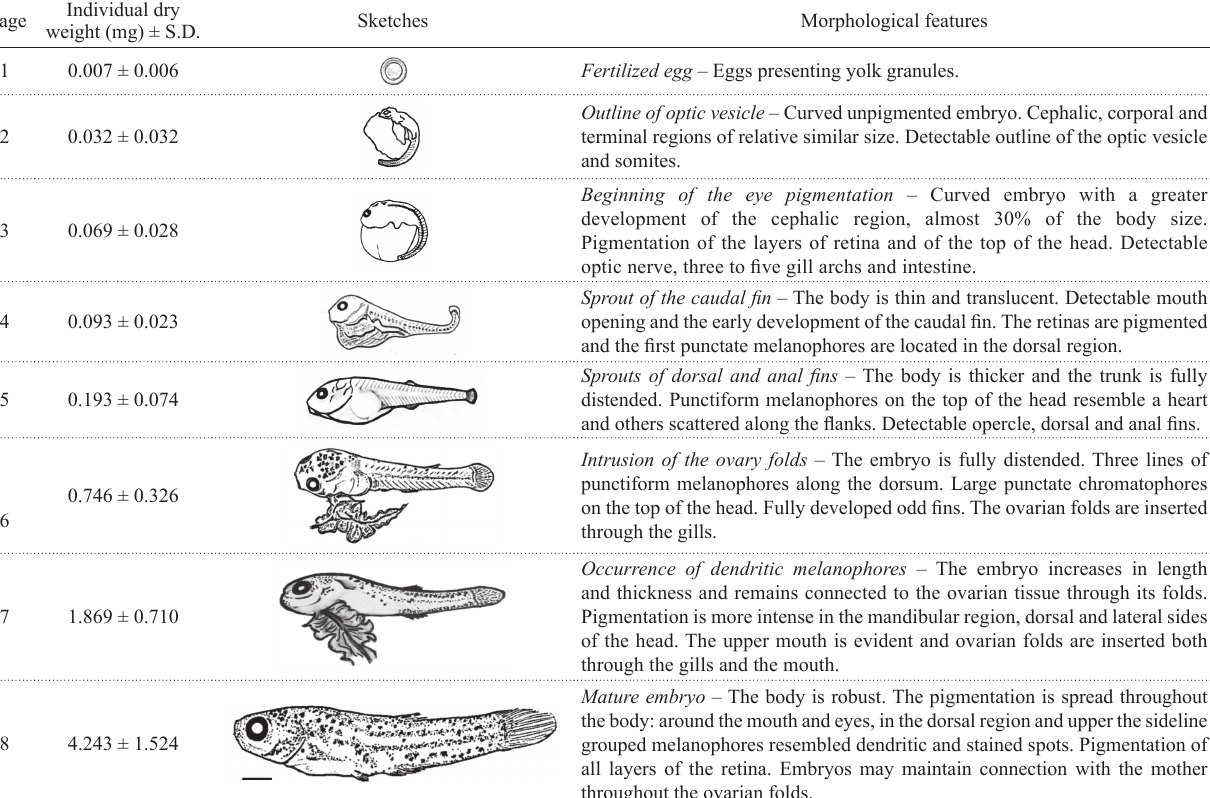
Table 1. Characterization of the embryos of the one-sided livebearer Jenynsia multidentata at the proposed eight stages of development. Scale bar of 0.5